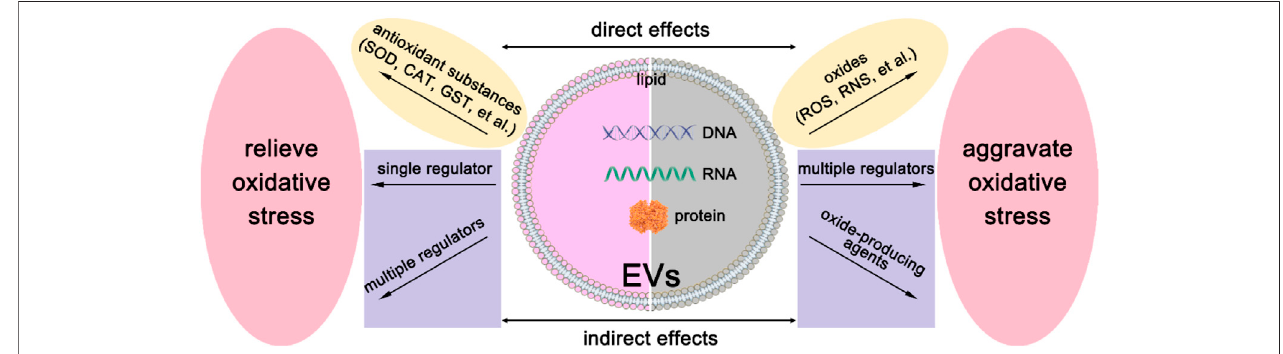
FIGURE 2 | The modulation mechanism of oxidative stress by EVs. There are direct effects and indirect effects of EVs on the modulation of oxidative stress. To relieve oxidative stress, EVs can directly deliver antioxidant substances, such as SOD, CAT, GST, et al., and indirectly deliver a single regulation factor or multiple regulators to recipient cells. For the aggravation of oxidative stress, EVs can deliver oxides such as ROS and RNS to recipient cells directly. Besides, oxide-producing agents or multiple regulators can be delivered to recipient cells to realize indirect